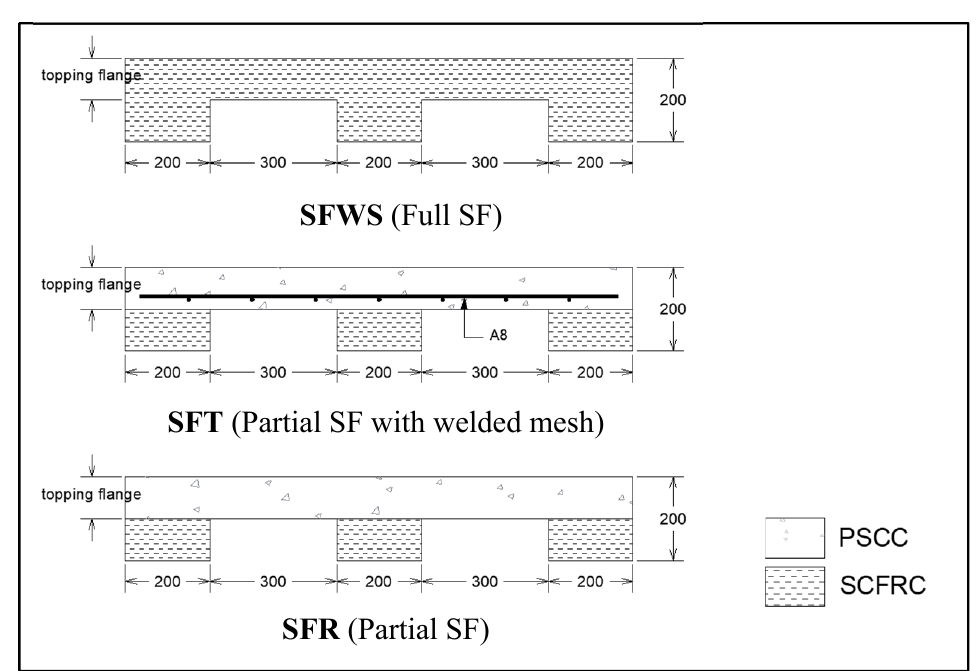
Table 3. SCFRC sample details.